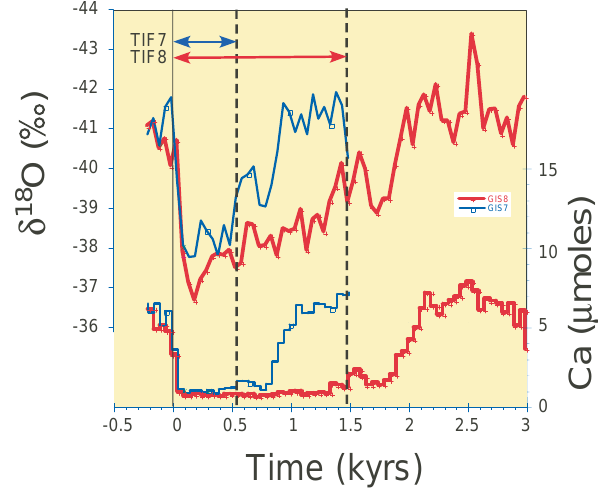
Fig. 9. Temporal evolution of the Dansgaard-Oeschger (DO) events 8 and 7 as expressed in GRIP ice-core data: δ 18 O (%, top) and cal- cium (Ca, representing dust) concentration (µM, bottom) (Johnsen et al., 2001) (from Rousseau et al., 2007 modified). The start of an event (time=0kyr) is given by the beginning of δ 18 O enrichment in the ice core records (vertical black line) (cf. Ganopolski and Rahm- storf, 2001). TIF: time interval favorable for soil development in Europe. We note that the correct denomination of DO interstadials (DOI) is Greenland Interstadials GIS (Rousseau et al.,